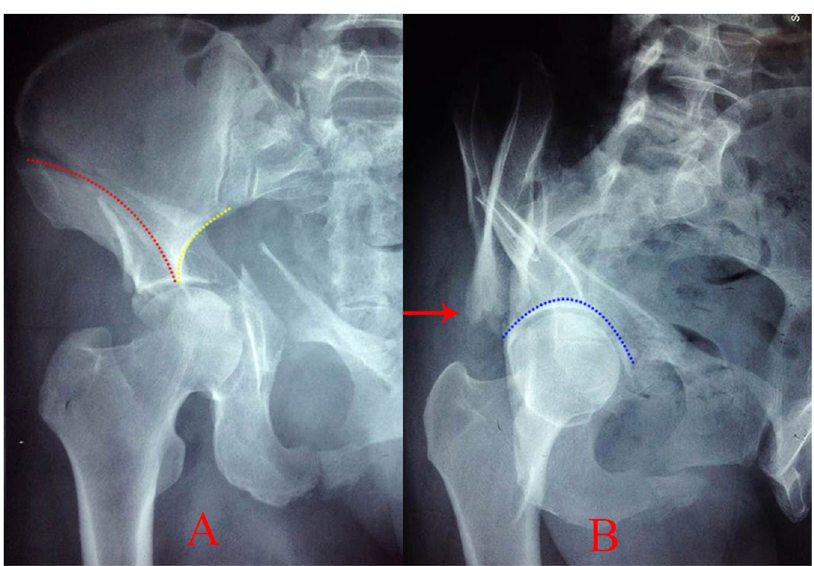
Figure 2. The radiographic characteristics of both-column fractures. ( A ) Iliac wing fracture line (red dotted line) and curved appearance (yellow dotted line), ( B ) the false congruence (blue dotted line) and the spur sign (arrow) are